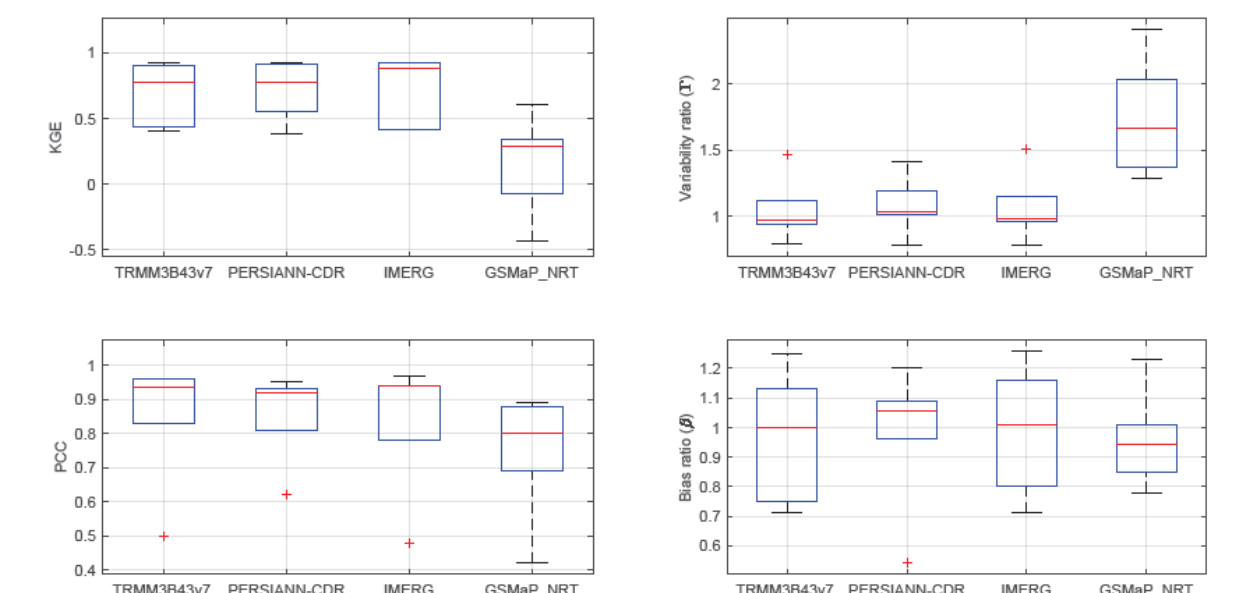
Remote Sens. 2021 , 13 , 1275 Figure 6. Statistical comparison of TRMM 3B43v7, PERSIANN-CDR, and IMERG compared with ground rainfall observation stations (GROS). The red plus signs (+) are the outliers in different statistical criteria.